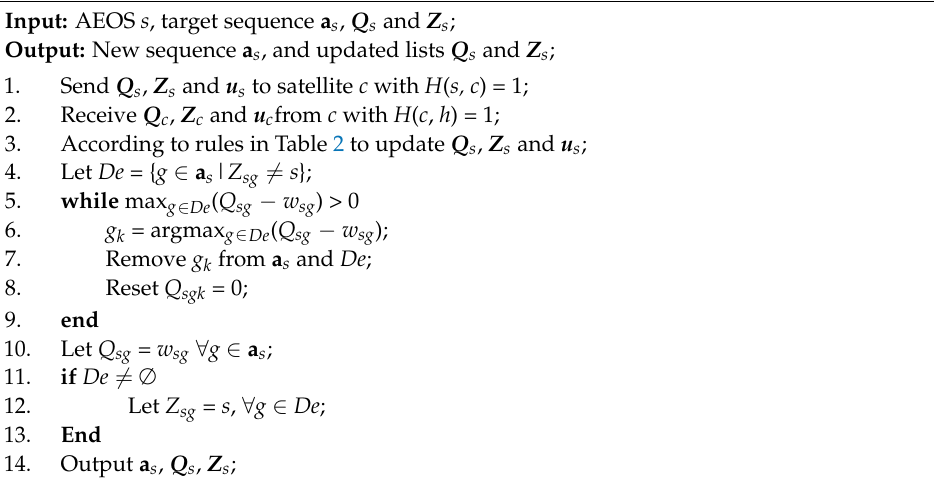
Algorithm 5 : Consensus and target removal phase running on each